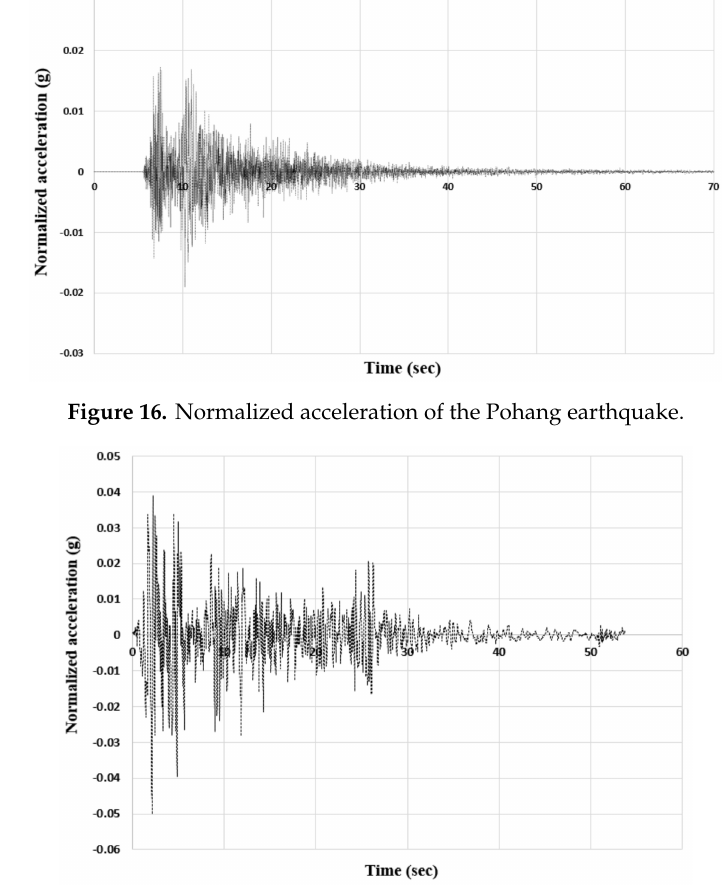
Figure 17. Normalized acceleration of the El Centro